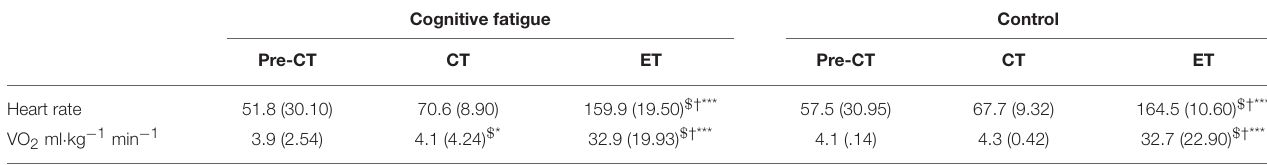
TABLE 2 | Descriptive statistics (M; SD ) and significance test for time period and fatigue type.